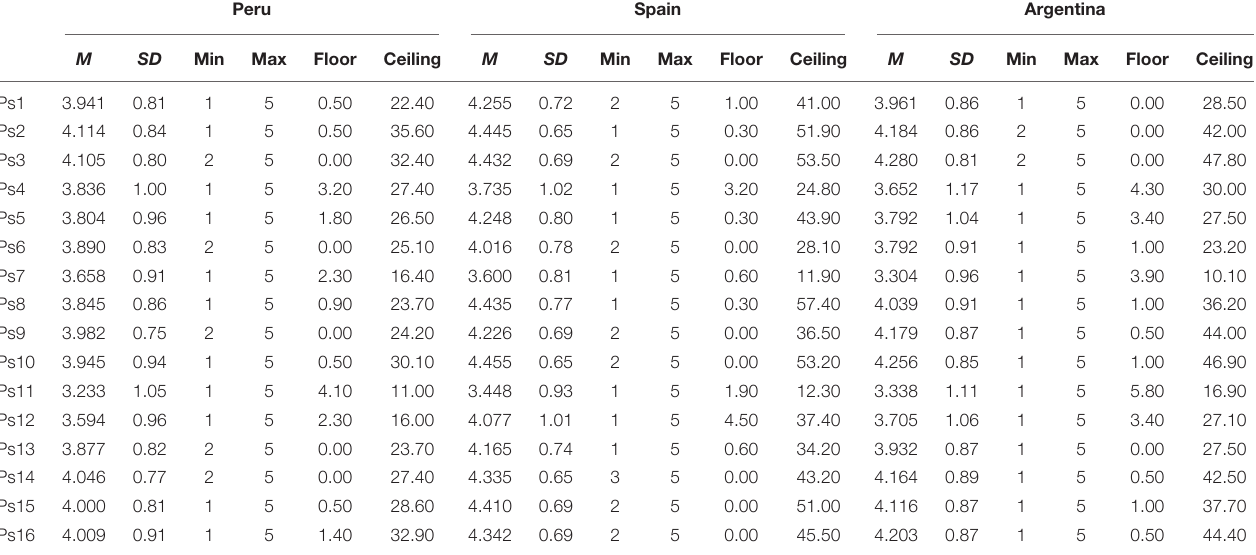
TABLE 2 | Statistical descriptive information of